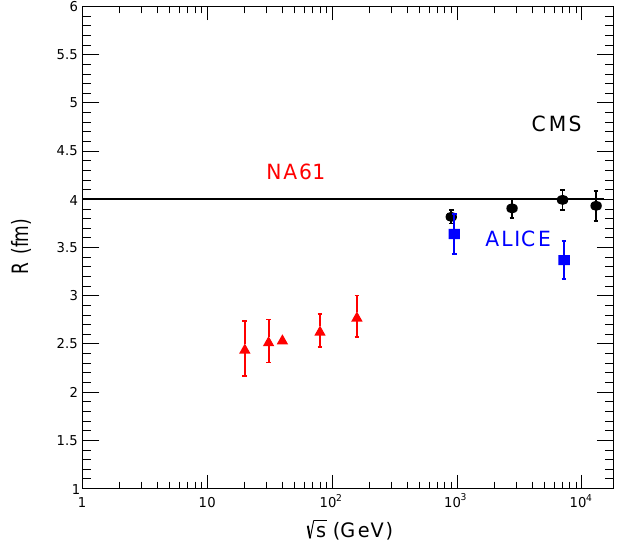
Figure 5. The energy dependence of the freeze-out radius R of pions in pp collisions. The round (red) points are obtained from fits to the results of the NA61/SHINE Collaboration [14] (see Table 5), the square (blue) points are for the ALICE Collaboration data (see Table 2), while the round (black) points are for the CMS Collaboration data (see Table 3). The straight line at R = 4 fm is there to guide the eye